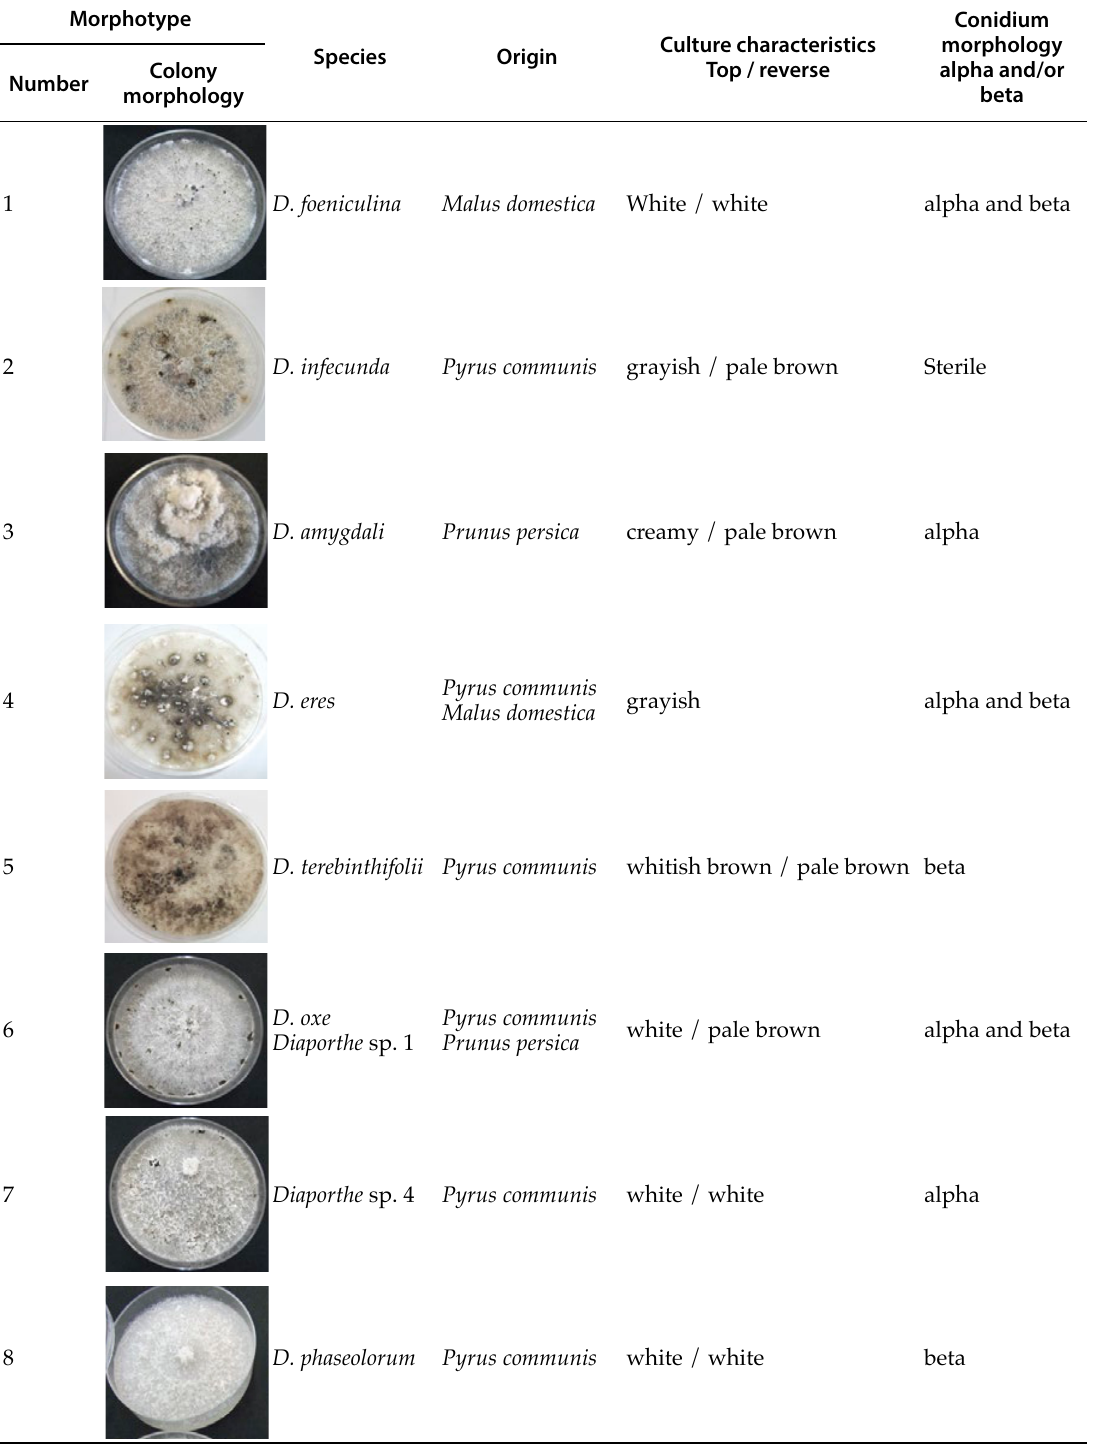
Table 1. Micro and macroscopic characteristics of Diaporthe